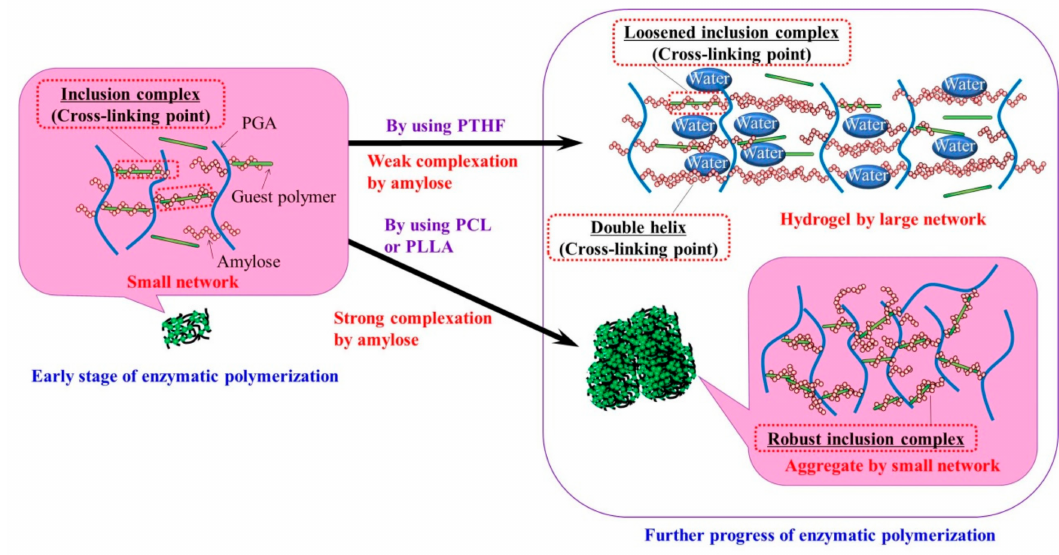
Figure 4. Image for formation of supramolecular networks with different sizes in accordance